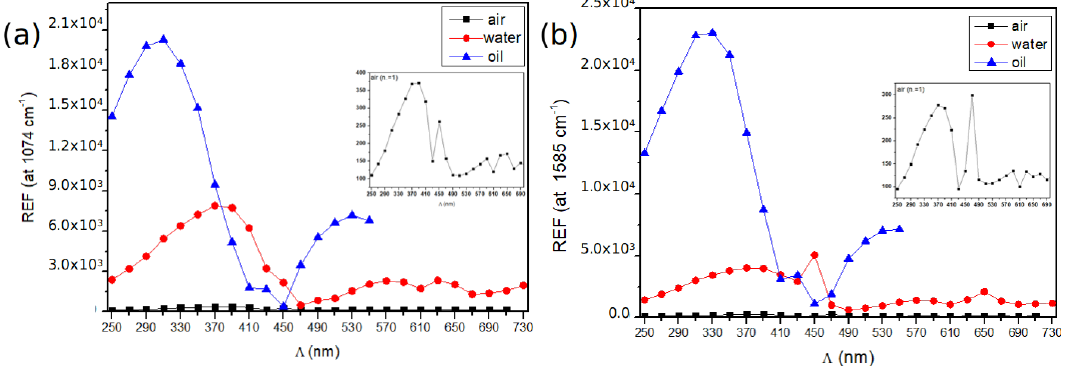
Figure 8. Calculated REFs calc in air (n a = 1), water (n w = 1.33) and oil (n o = 1.518) at: 1074 cm − 1 ( a ) and 1585 cm − 1 ( b ) for arrays of gold nanodiscs. Diameter of the disc is D = 100 nm, the height h = 50 nm and grating constant varying from Λ = 250 to 730 nm. The REFs are calculated using the FDTD method. The experimental SERS measurements in oil have been investigated using a microscope objective (50x, N.A. 0.9), with an excitation line λ exc = 632.8 nm and a laser power of 65 µ W. The experimental REFs vary from 2 × 10 6 (for Λ = 510 nm) to 10 7 (for Λ = 270 nm). Figure 9 compares the experimental REFs versus the grating constant with the calculated REFs in oil. For both Raman lines, there is a good qualitative agreement between the experimental and calculated profile of the REFs versus the grating constant. In particular, the maximum of REF is obtained for a smaller grating constant for the 1074 cm − 1 Raman line (at Λ = 300 nm), compared to the REF for the 1585 cm − 1 Raman line (at Λ = 330